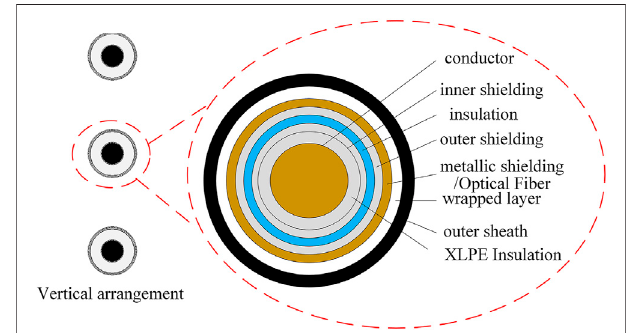
FIGURE 4 | Schematic diagram of multi-layer structure of typical single- core cable.